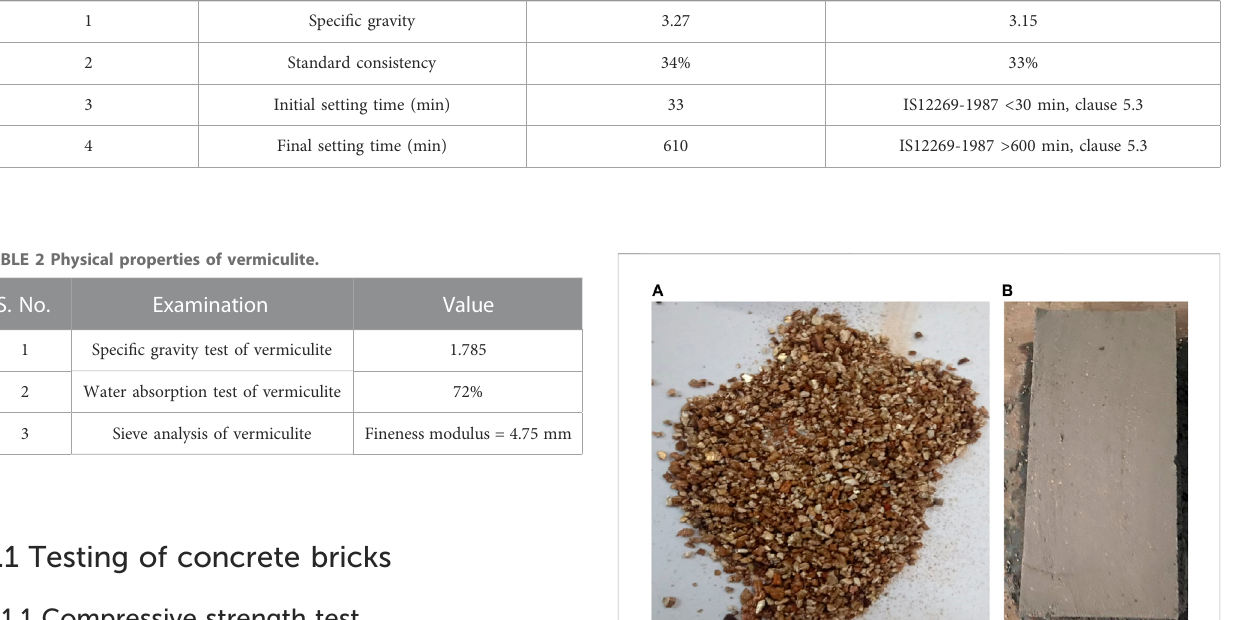
TABLE 1 Properties of ordinary Portland cement. S. No.